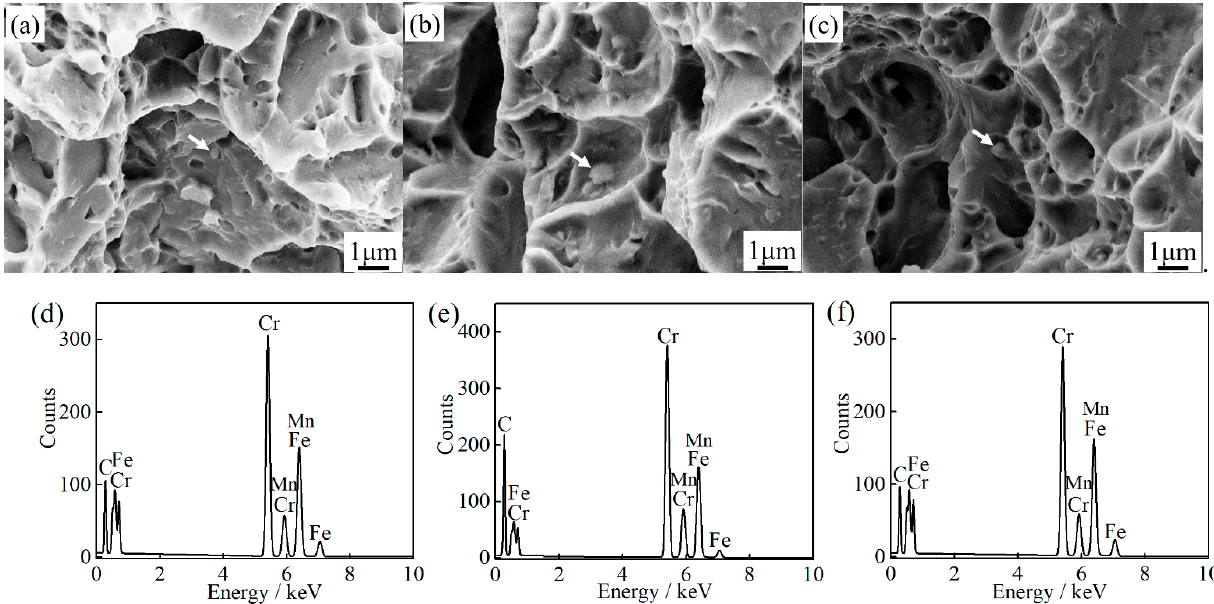
Figure 15. The impact fracture morphology of ( a ) 1000-P; ( b ) 1020-P; ( c ) 1040-P, with the corresponding dispersed energy of carbides (the area showed by white arrow); ( d ) 1000-P; ( e ) 1020-P; and ( f ) 1040-P.